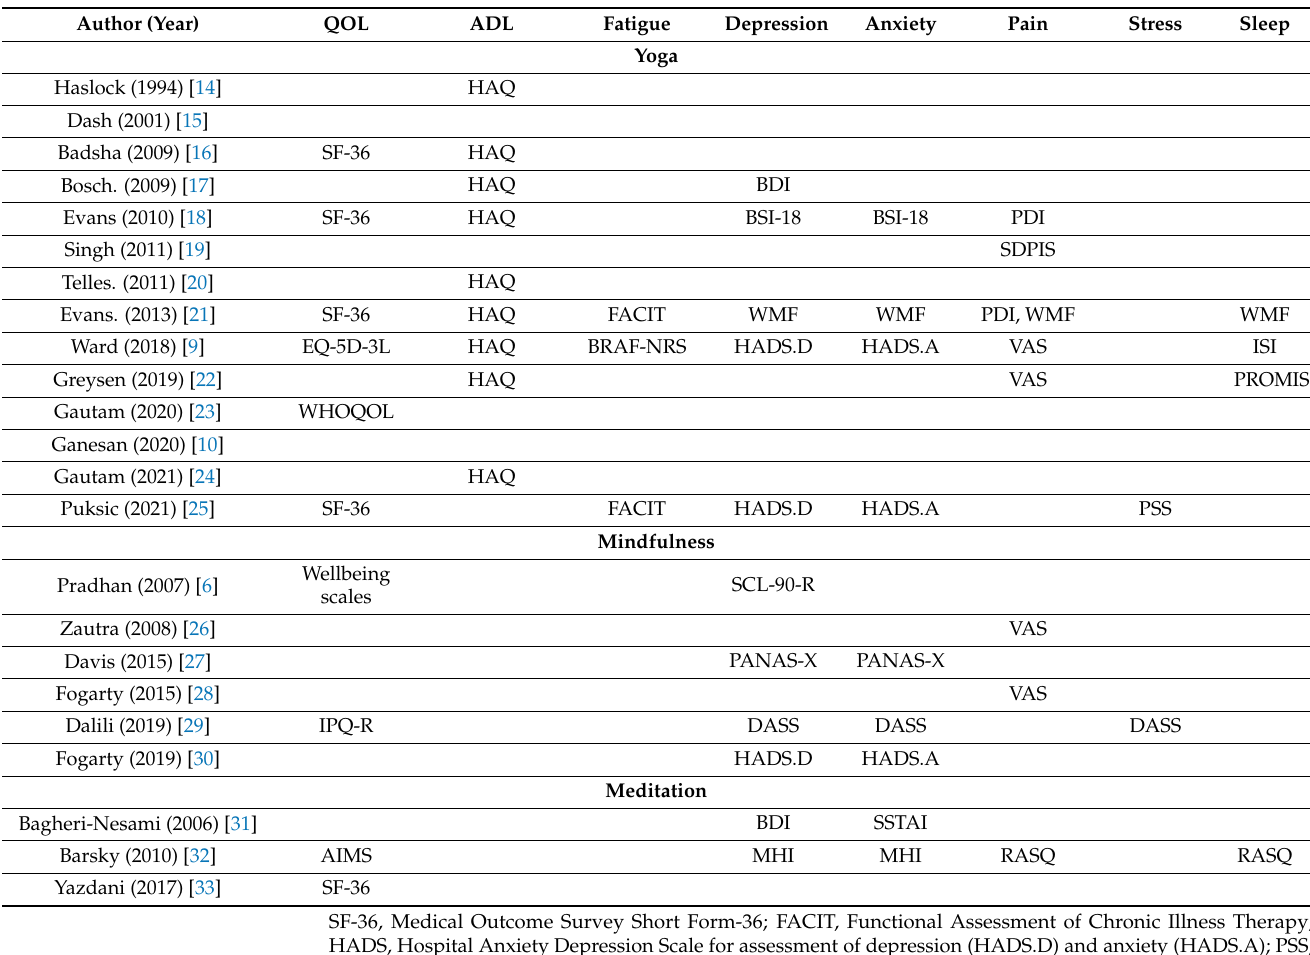
Table 2. Patient-reported psychosocial outcomes and tools in each